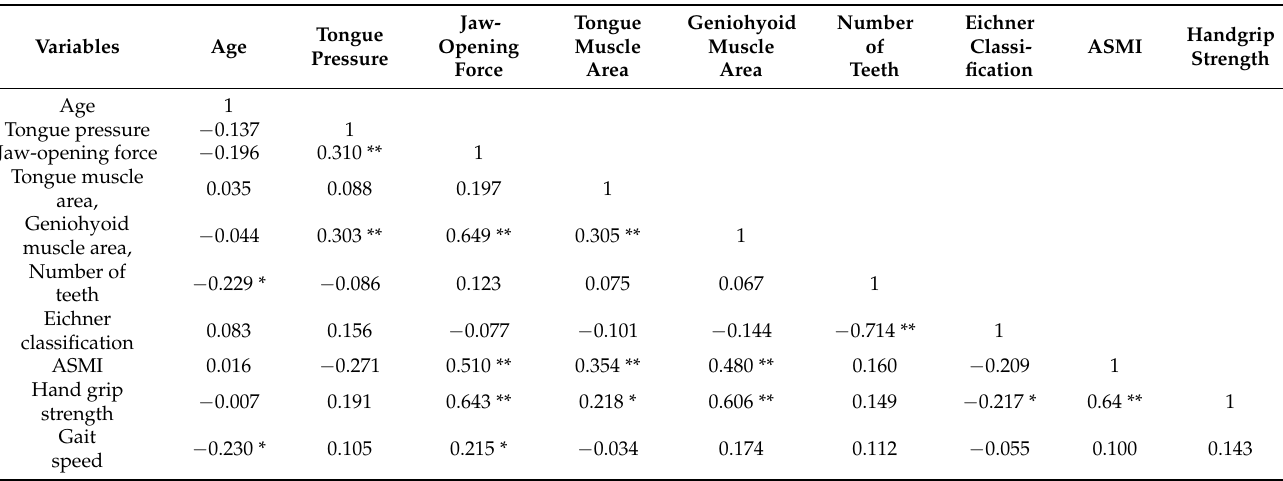
Table 4. Spearman correlation coefficient analysis results of the correlations among study variables.